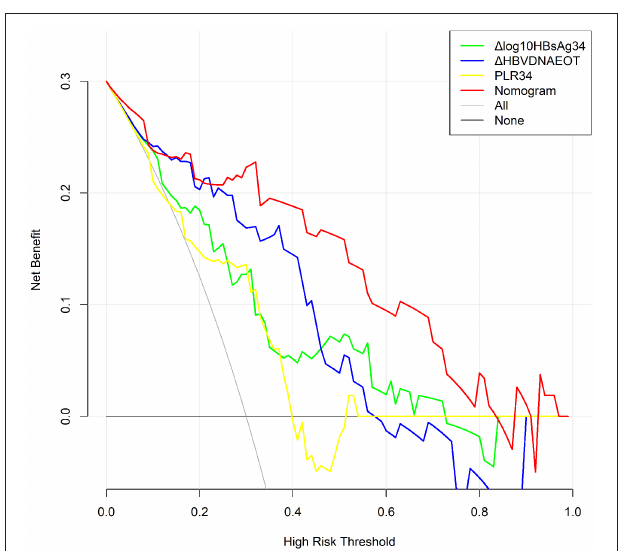
FIGURE 3 | Decision curve for the non-rebound outcome predictive model. All, Presume that all patients do not rebound after treatment withdrawal. None, Presume that all patients rebound after treatment withdrawal. In the range of 0.3–0.8, the final complex model showed a higher net benefit rate than a single index. The clinical application was positively correlated with the area under the